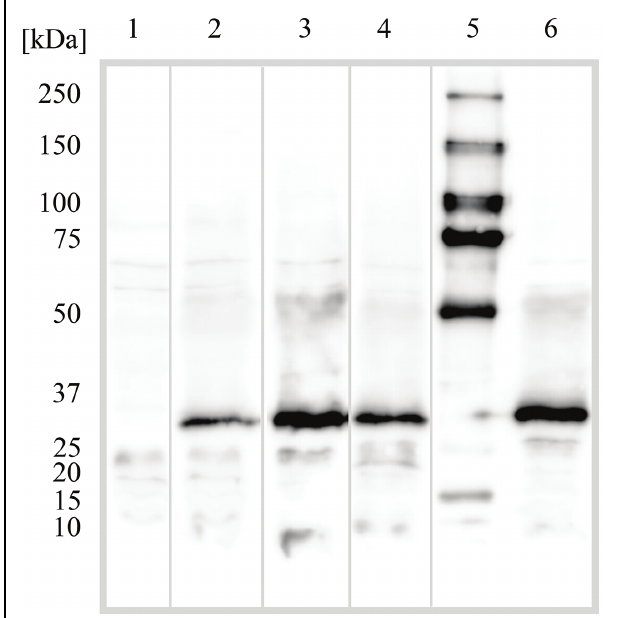
FIGURE 6 | Western blot detection of the BC3310 protein and its mutants in Escherichia coli . E. coli DH5 α (cid:2) acrAB was transformed with empty pTTQ18 vector plasmid or pTTQ18 with the indicated insert; wild type BC3310 with his-tag and mutants D105N, D105A, and D105E under an IPTG inducible promoter. The cells were grown and prepared for SDS-PAGE as described in Section “Materials and Methods”. Numbers indicate: (1) empty pTTQ18 vector; (2) BC3310 wild type; (3) D105N mutant; (4) D105A mutant; (5) molecular weight marker; (6) D105E mutant. BC3310 and its mutants migrate at ∼ 30 kDa.